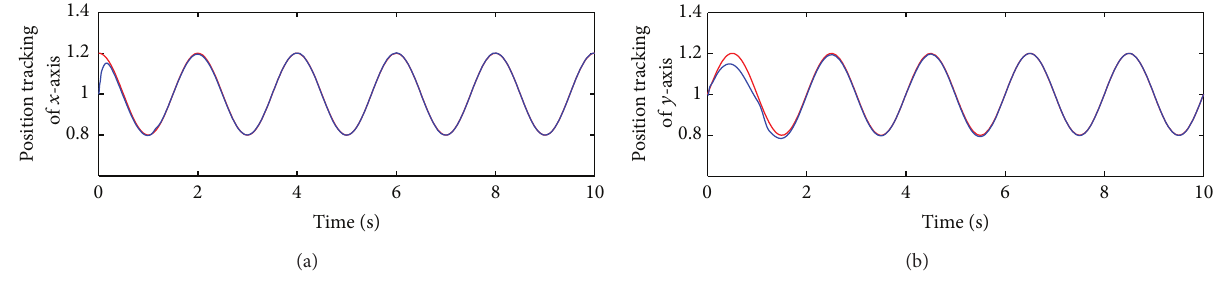
Figure 2: Position tracking of the end